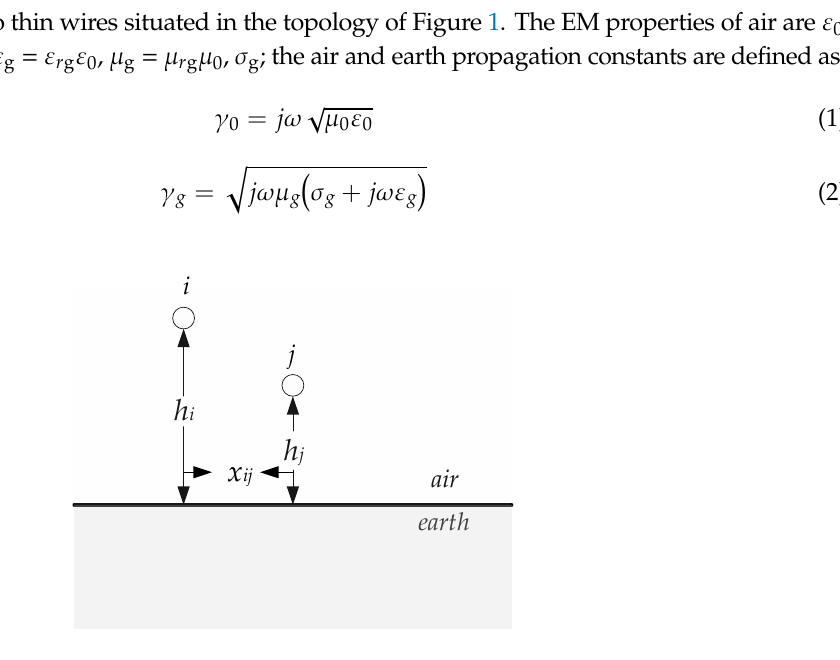
Figure 1. Two-wire configuration located in air above homogenous earth.